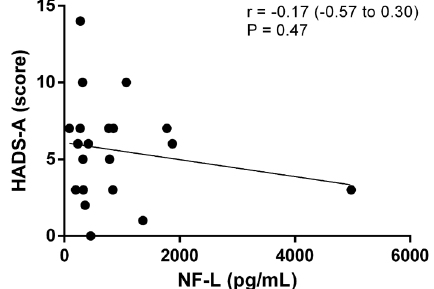
Figure 5. Correlation analysis between scores of the Beck Depression Inventory Scale (BDI) and neuro fi laments light chain (NF-L) levels.